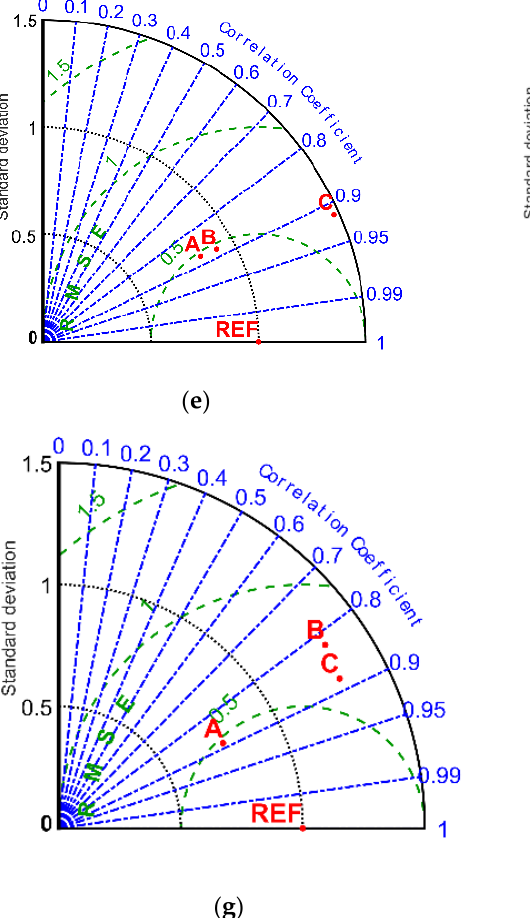
Table 4. Forecasting results and precision analysis of precipitation at different time scales from 2019 to 2023